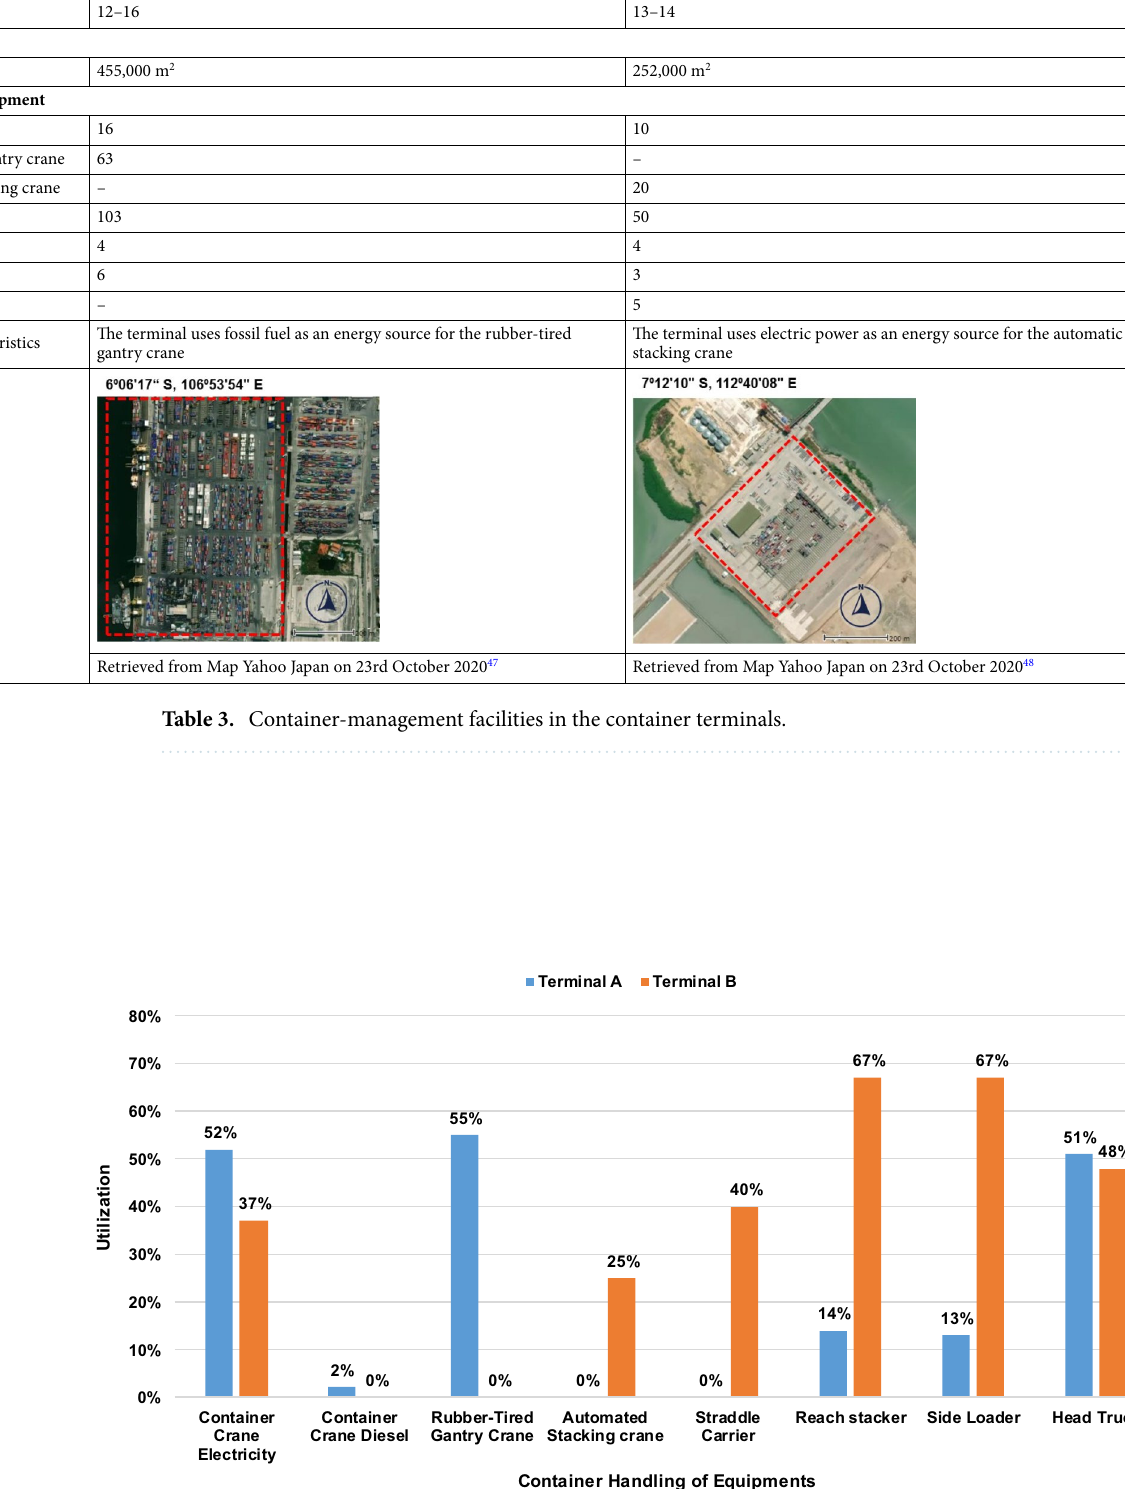
Figure 2. Utility of container-handling equipment observed in the container